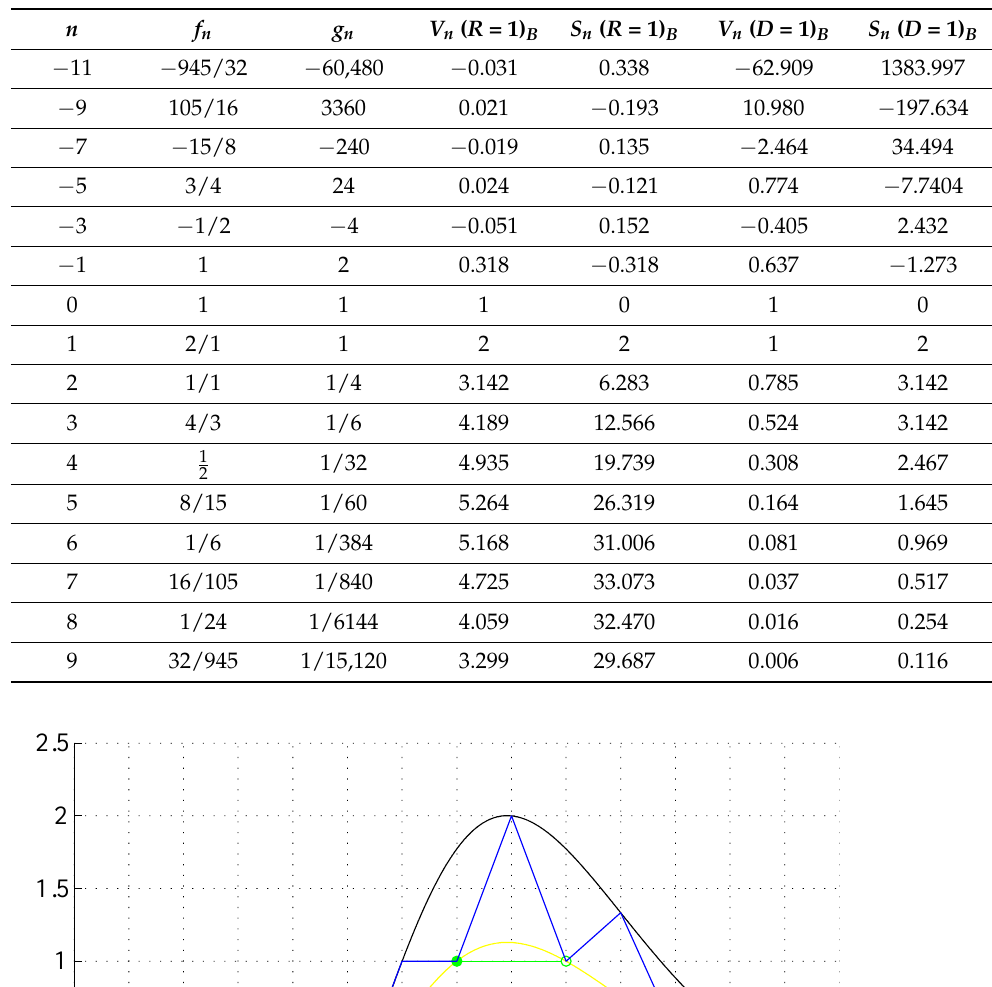
Table 1. Volumes and surfaces of n -balls for − 11 ≤ n ≤ 9.